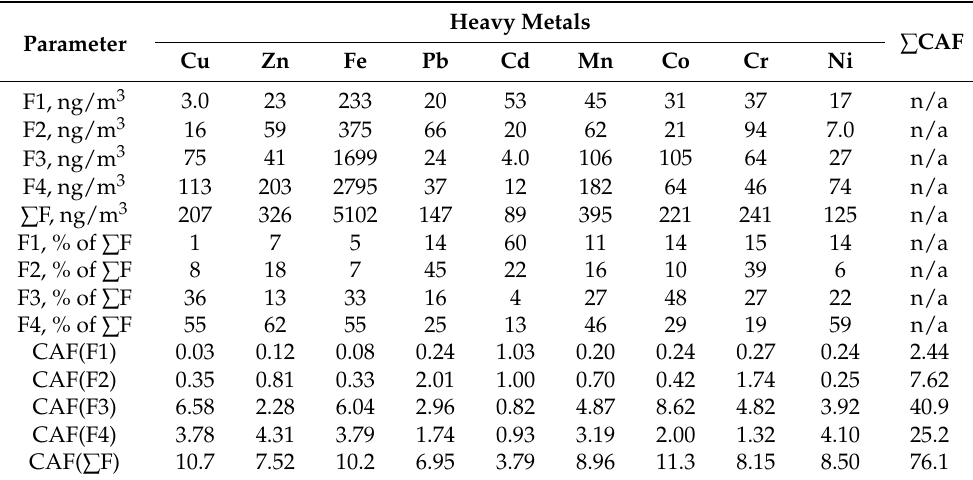
Table 3. Results of HMs fractionation in atmospheric PM 10 of Pune city and levels of chemical affinity factor (CAF)—calculated from the data of R. Jan et al.